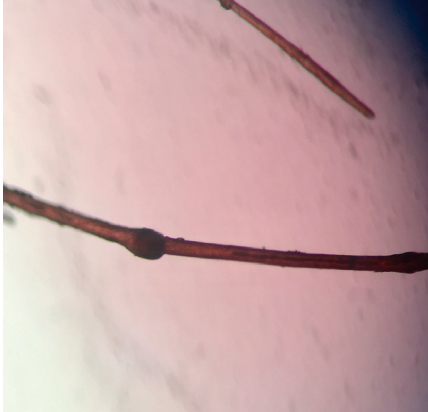
Figure 2: Trichoscopic examination of the child’s scalp hair showing trichorrhexis invaginata (bamboo hair).